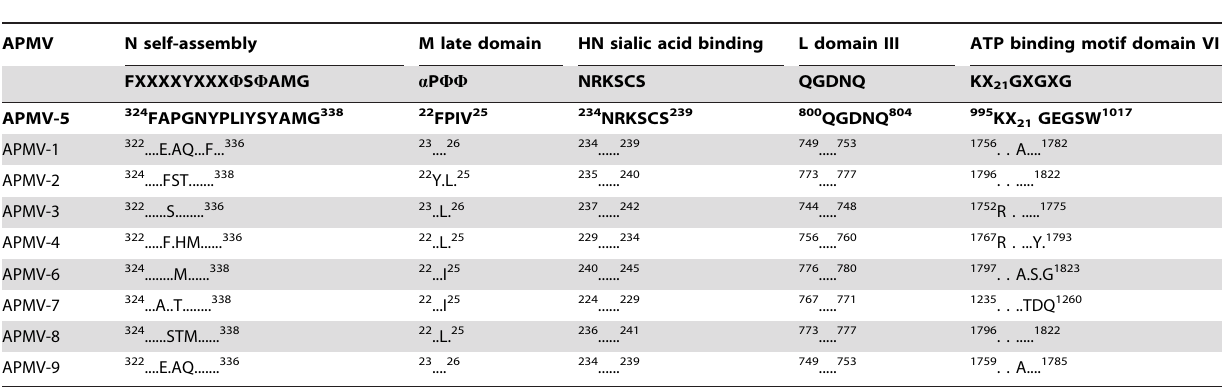
Table 4. Comparison of amino acid sequence motifs observed in the N, M, HN and L proteins of prototype strains of the nine APMV